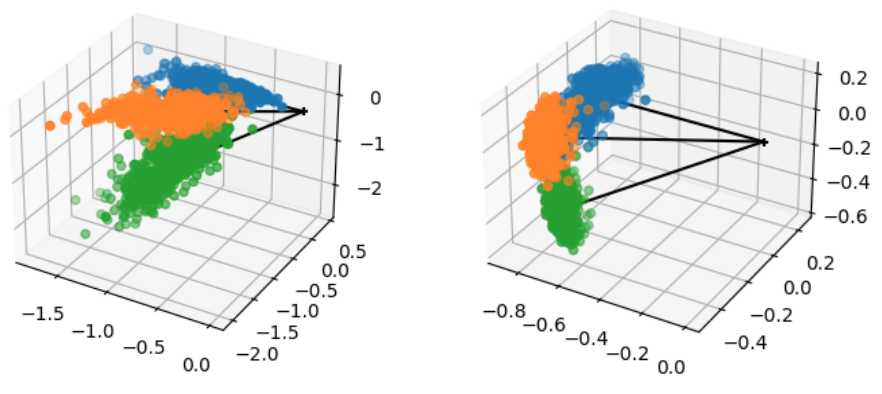
Figure 3. Plot of feature vectors (extracted from WRN) from 3 randomly selected classes (each with its own color). ( left ) Naive features. ( right ) Preprocessed features using power transform.